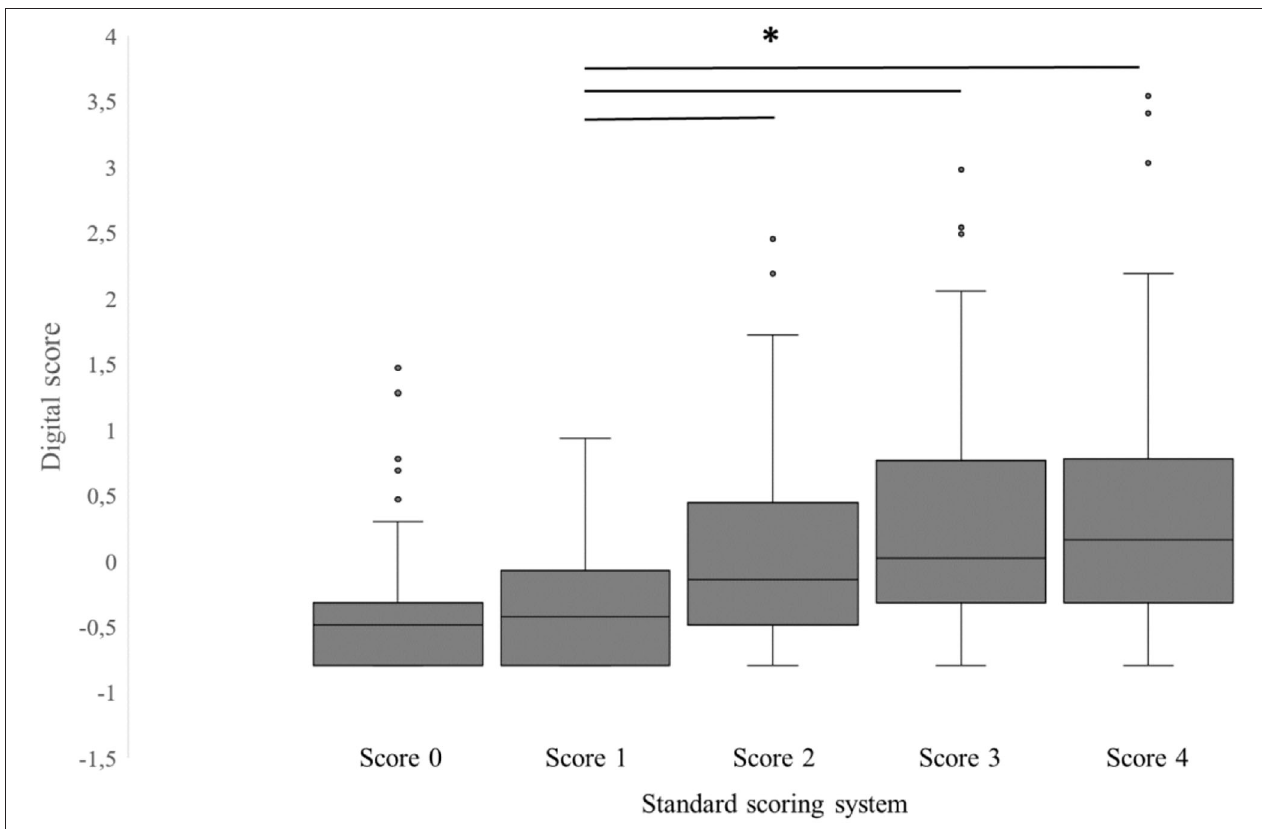
FIGURE 5 | Boxplots of the digital score [factor revealed from principal component analysis (PCA)] vs. the standard FPD scoring system of the metatarsal pad (score 0 = intact foot; score 1 = alterations ≤ 10%; score 2 = alterations ≤ 25%; score 3 = alterations ≤ 50% and score 4 = alterations > 50%). Data are presented as boxplots (data range, median, lower quartile, and upper quartile; outliers are included in the graph as dots), *indicates a p < 0.05, n = 500